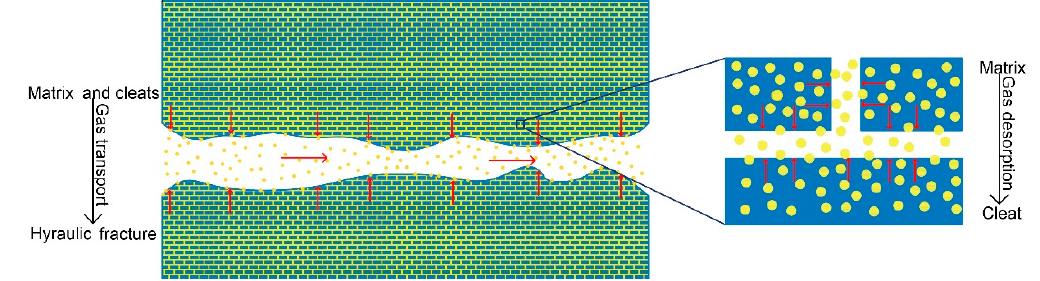
Figure 2. Different types of gas flow at different scales. Figure 2. Di ff erent types of gas flow at di ff erent